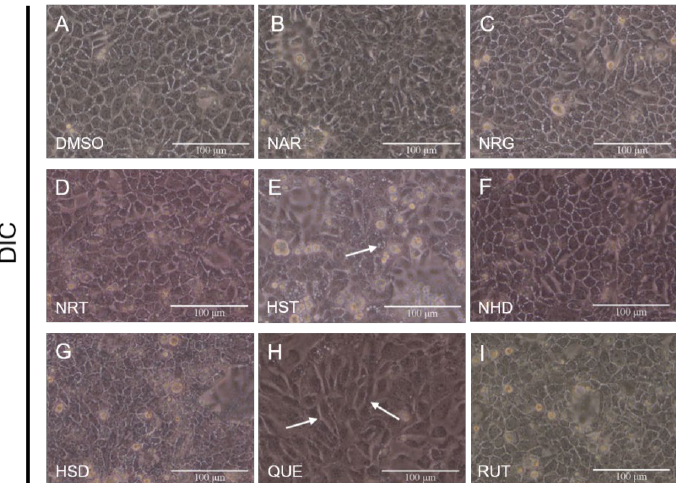
Figure 2. Effects of flavonoids on the morphology of Madin–Darby canine kidney (MDCK) II cells. Bright-field di ff erential interference contrasts (DIC) for the images with corresponding flavonoids that are arrayed. Cells were treated with flavonoids at a concentration of 100 μM for 48 h (we decided this condition from the result of Supplementary Figure S2). Arrows indicate the changes. ( A ) Control (DMSO), ( B ) NAR, ( C ) NRG, ( D ) NRT, ( E ) HST, ( F ) NHD, ( G ) HSD, ( H ) QUE, and ( I ) RUT. Scale bar